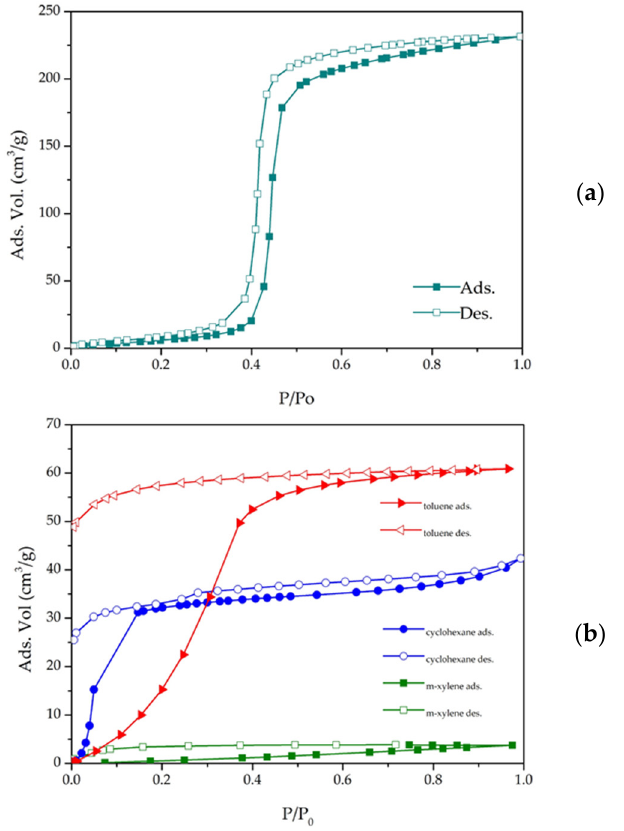
Figure 11. ( a ) Isotherm of water at 25 °C; ( b ) isotherms of toluene, cyclohexane and m-xylene at 25 °C. Table 4 lists the following properties of the VOCs studied: density, kinetic diameter (D), molecular cross-sectional area ( σ ), quantity of VOC adsorbed on the MOF (Q 0 ) and adsorption capacity in volume (V). Table 4. Properties of selected